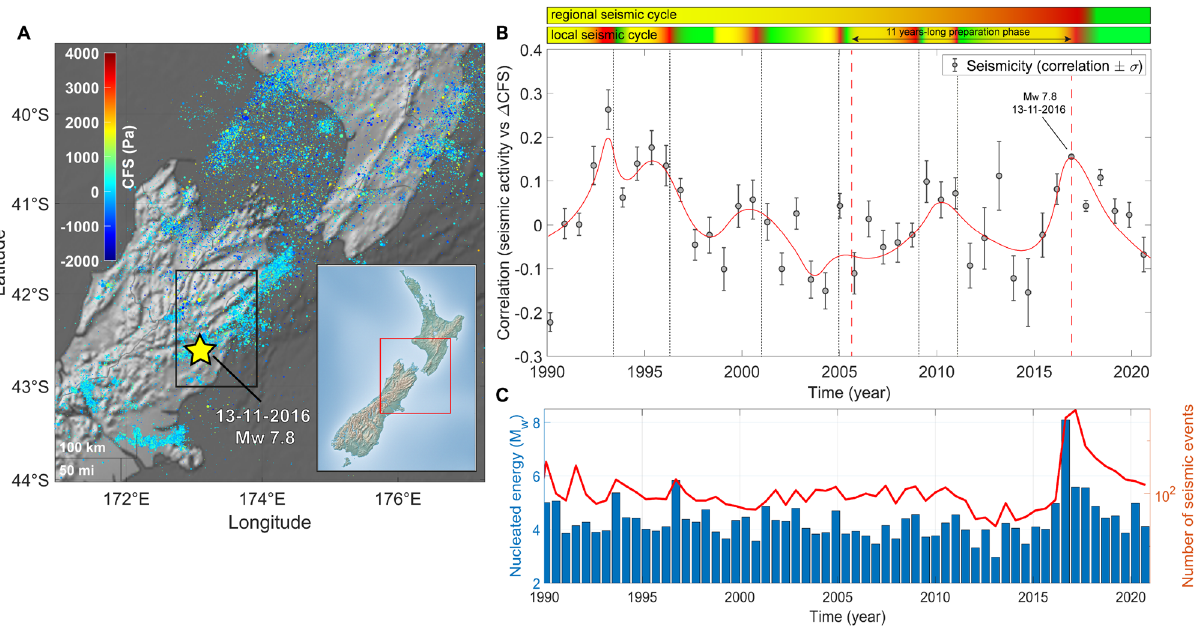
Figure 3. ( A ) (cid:31) CFS map for seismicity in the Christchurch region, South Island, New Zealand, GeoNet Catalog, 1990−2021, M L ≥ 2.5. The map is realized using the functions “geoscatter” and “geobasemap” in the Matlab environment 63 . ( B ) Correlation ρ between (cid:31) CFS and seismicity in the Kaikoura District, South Island, New Zealand (latitude 42.1°−43.1° S and longitude 172.7°−173.9° E, depth 0−33 km, M L ≥ 2.5) between 1990 and 2021. The red line is a weighted smoothing spline. Two horizontal color bars above the scatter-plot show nested “seismic cycles” whose phases are highlighted by different colors (green for the post-seismic phase, the interseismic one is in yellow and the coseismic phase is in red). ( C ) Histogram of energy nucleated by earthquakes with M L ≥ 2.5 (blue bars) and plot of the number of recorded seismic events (red